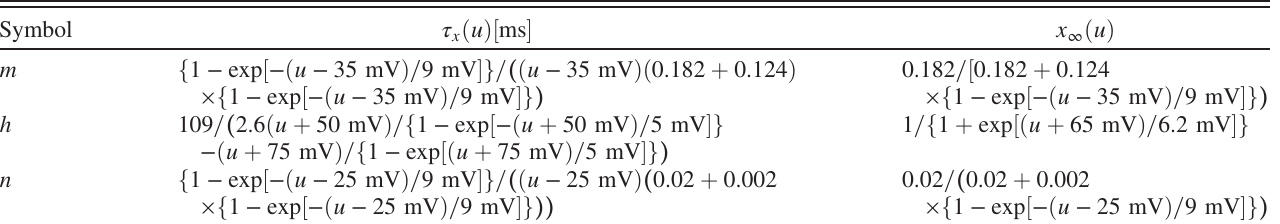
TABLE I. Hodgkin-Huxley kinetics for three types of voltage-gated ion channels. Parametrization follows experiments in neocortical neurons [74 –